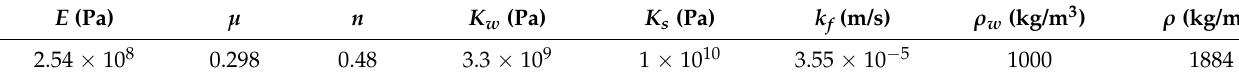
Figure 1. Geometry and boundary conditions of a fully saturated soil column. Table 1. Soil properties of the fully saturated soil column.